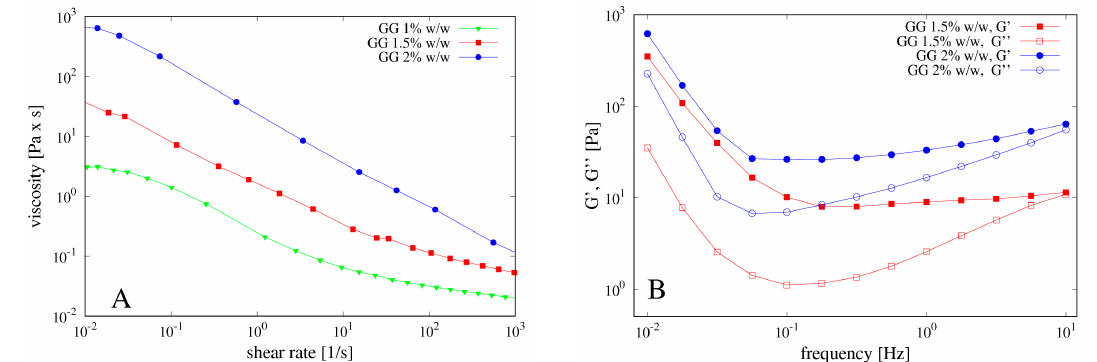
Figure 4. ( A ) Flow curves of gellan gum (GG) at different concentrations 1%, 1.5% and 2% w/w ; ( B ) corresponding mechanical spectra.